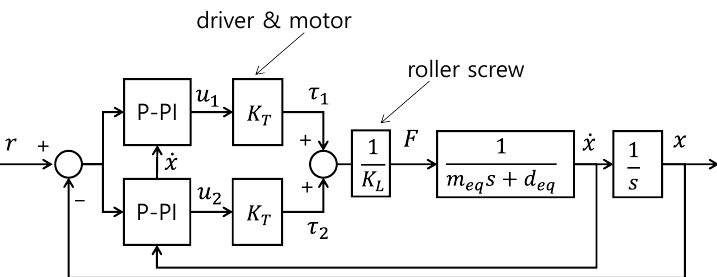
Figure 6. Block diagram of the actuator position control by two motors.